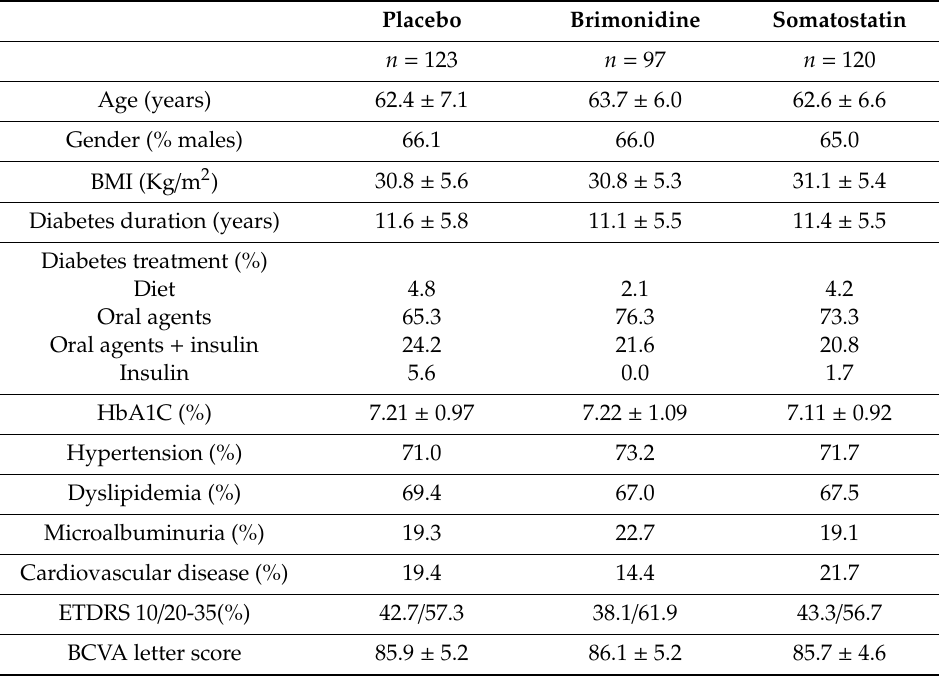
Table 2. Baseline characteristics of type 2 diabetes mellitus patients included in the analysis of e ffi cacy.